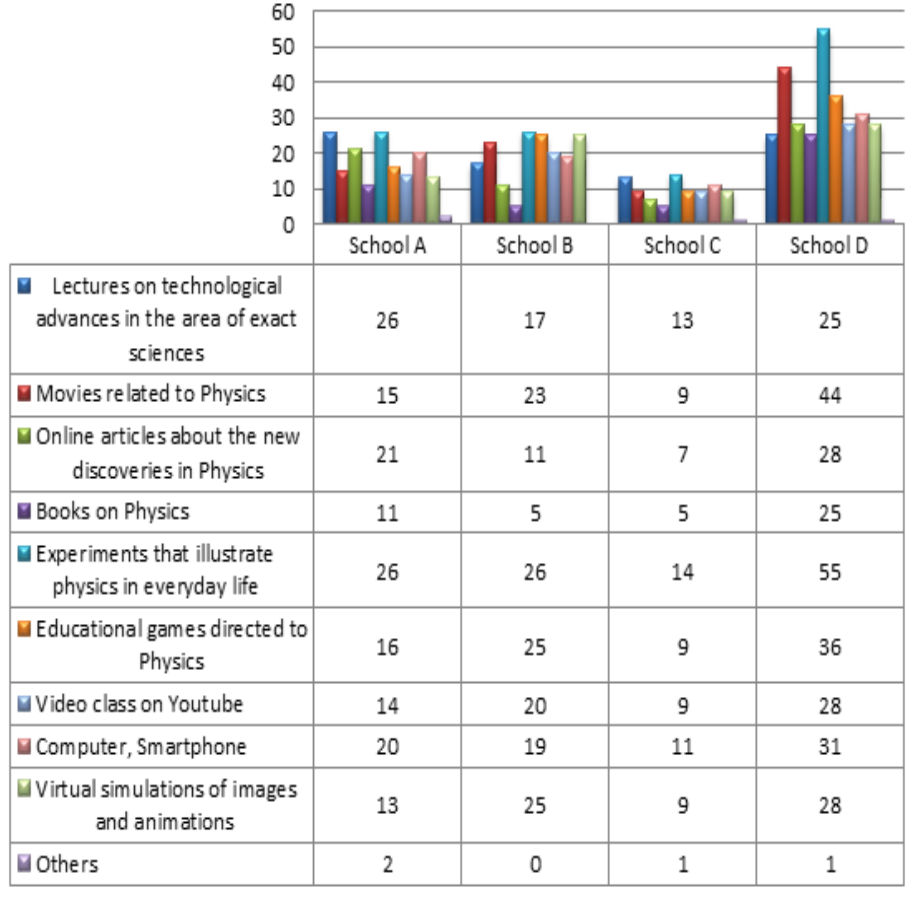
Figure 3 : List of the most interesting means, considered by the students, to learn Physics.